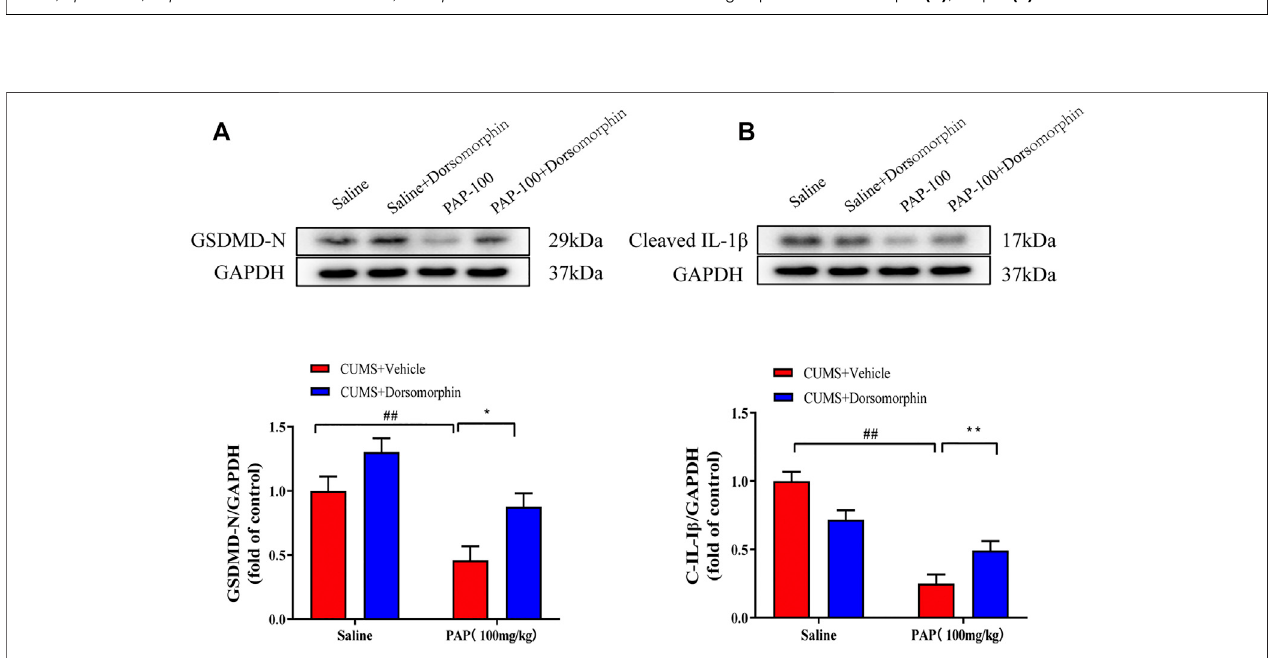
FIGURE7| Role ofAMPK intheattenuationofPAPonCUMS-inducedprotein changes . Theexpressions ofGSDMD-N (A) and Cleaved-IL-1 β (B) inhippocampal tissues. ## p < 0.01 vs. CUMS + Vehicle, * p < 0.05, and ** p < 0.01 vs. CUMS + Vehicle + PAP group.